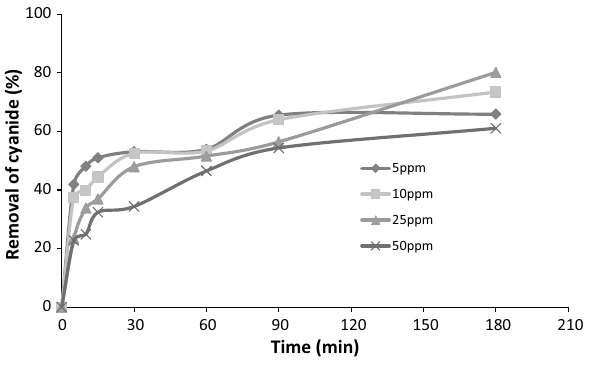
Fig. 5 Variation of removal of cyanide with time considering IC as input